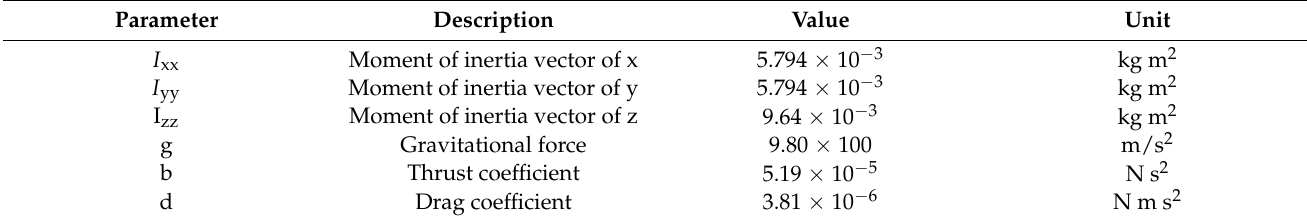
Figure 4. Parameter optimization curve. Table 3. Parameters of the test quadrotor.